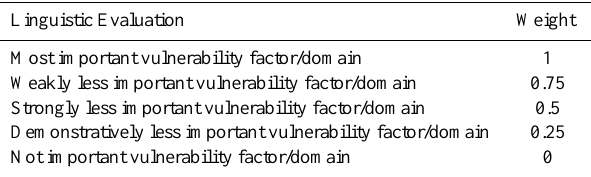
Table 6. Linguistic evaluations supporting the expert/decision maker in the assignation of scores to vulnerability factors.